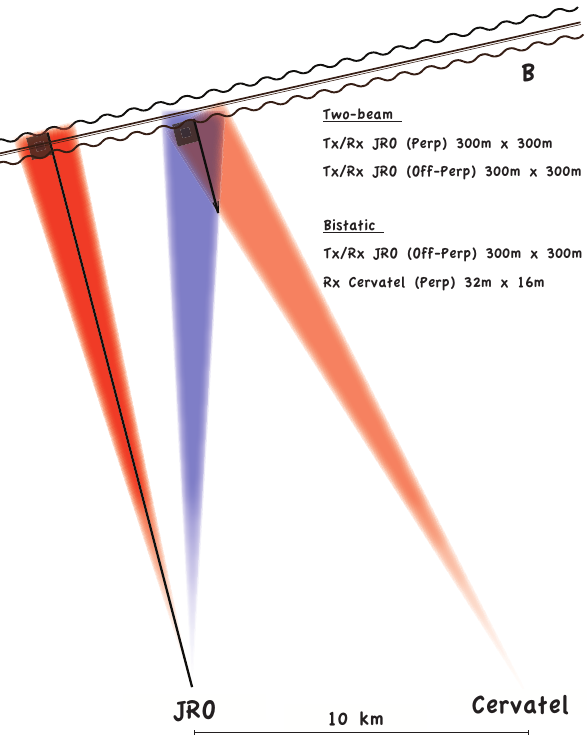
Fig. 1. Experiment configuration. (a) The two-beam configu- ration uses two independent beams from Jicamarca to point per- pendicular (dark red) and off-perpendicular (blue), respectively. (b) The bistatic configuration uses one Jicamarca beam to point off-perpendicular (blue) and simultaneously a beam from Cervatel (ligh red) is used for reception. The combined Cervatel-Jicamarca link points perpendicular to B at 150-km altitude. The separation between sites is ∼